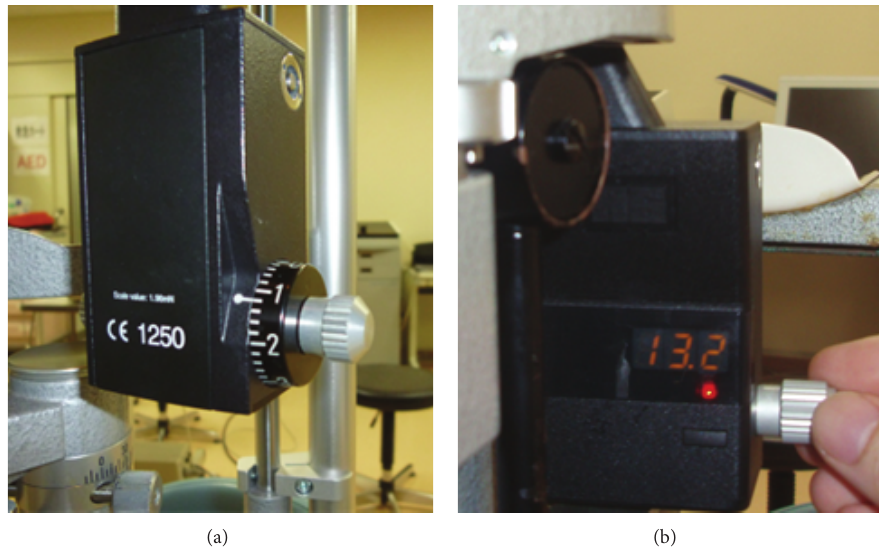
Figure 1: (a) The standard Goldmann applanation tonometer (sGAT: AT900, Haag-Streit International, Koeniz, Switzerland); and (b) the digital Goldmann applanation tonometer (dGAT: AT900D, Haag-Streit International).